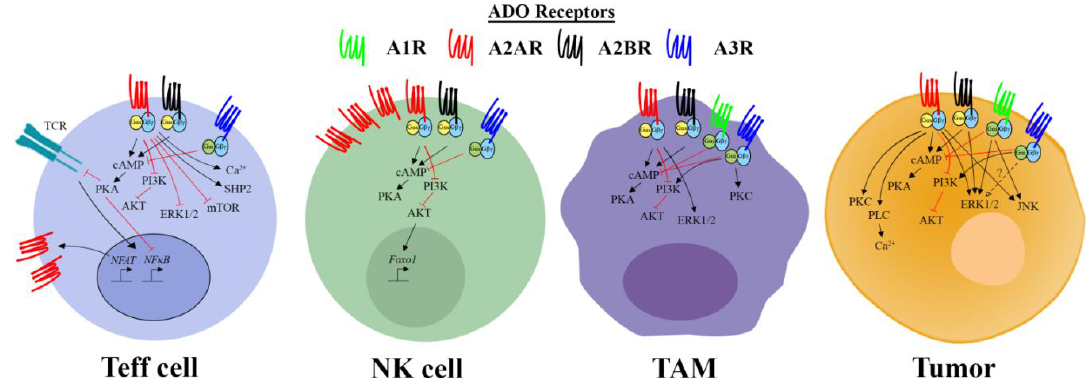
Figure 2. Expression of adenosine receptors and their downstream signalling pathways within various immune cell subsets and tumor cells in the context of the TME. Arrows indicate increased expression or activation. T bars indicate inhibition or reduced activity.